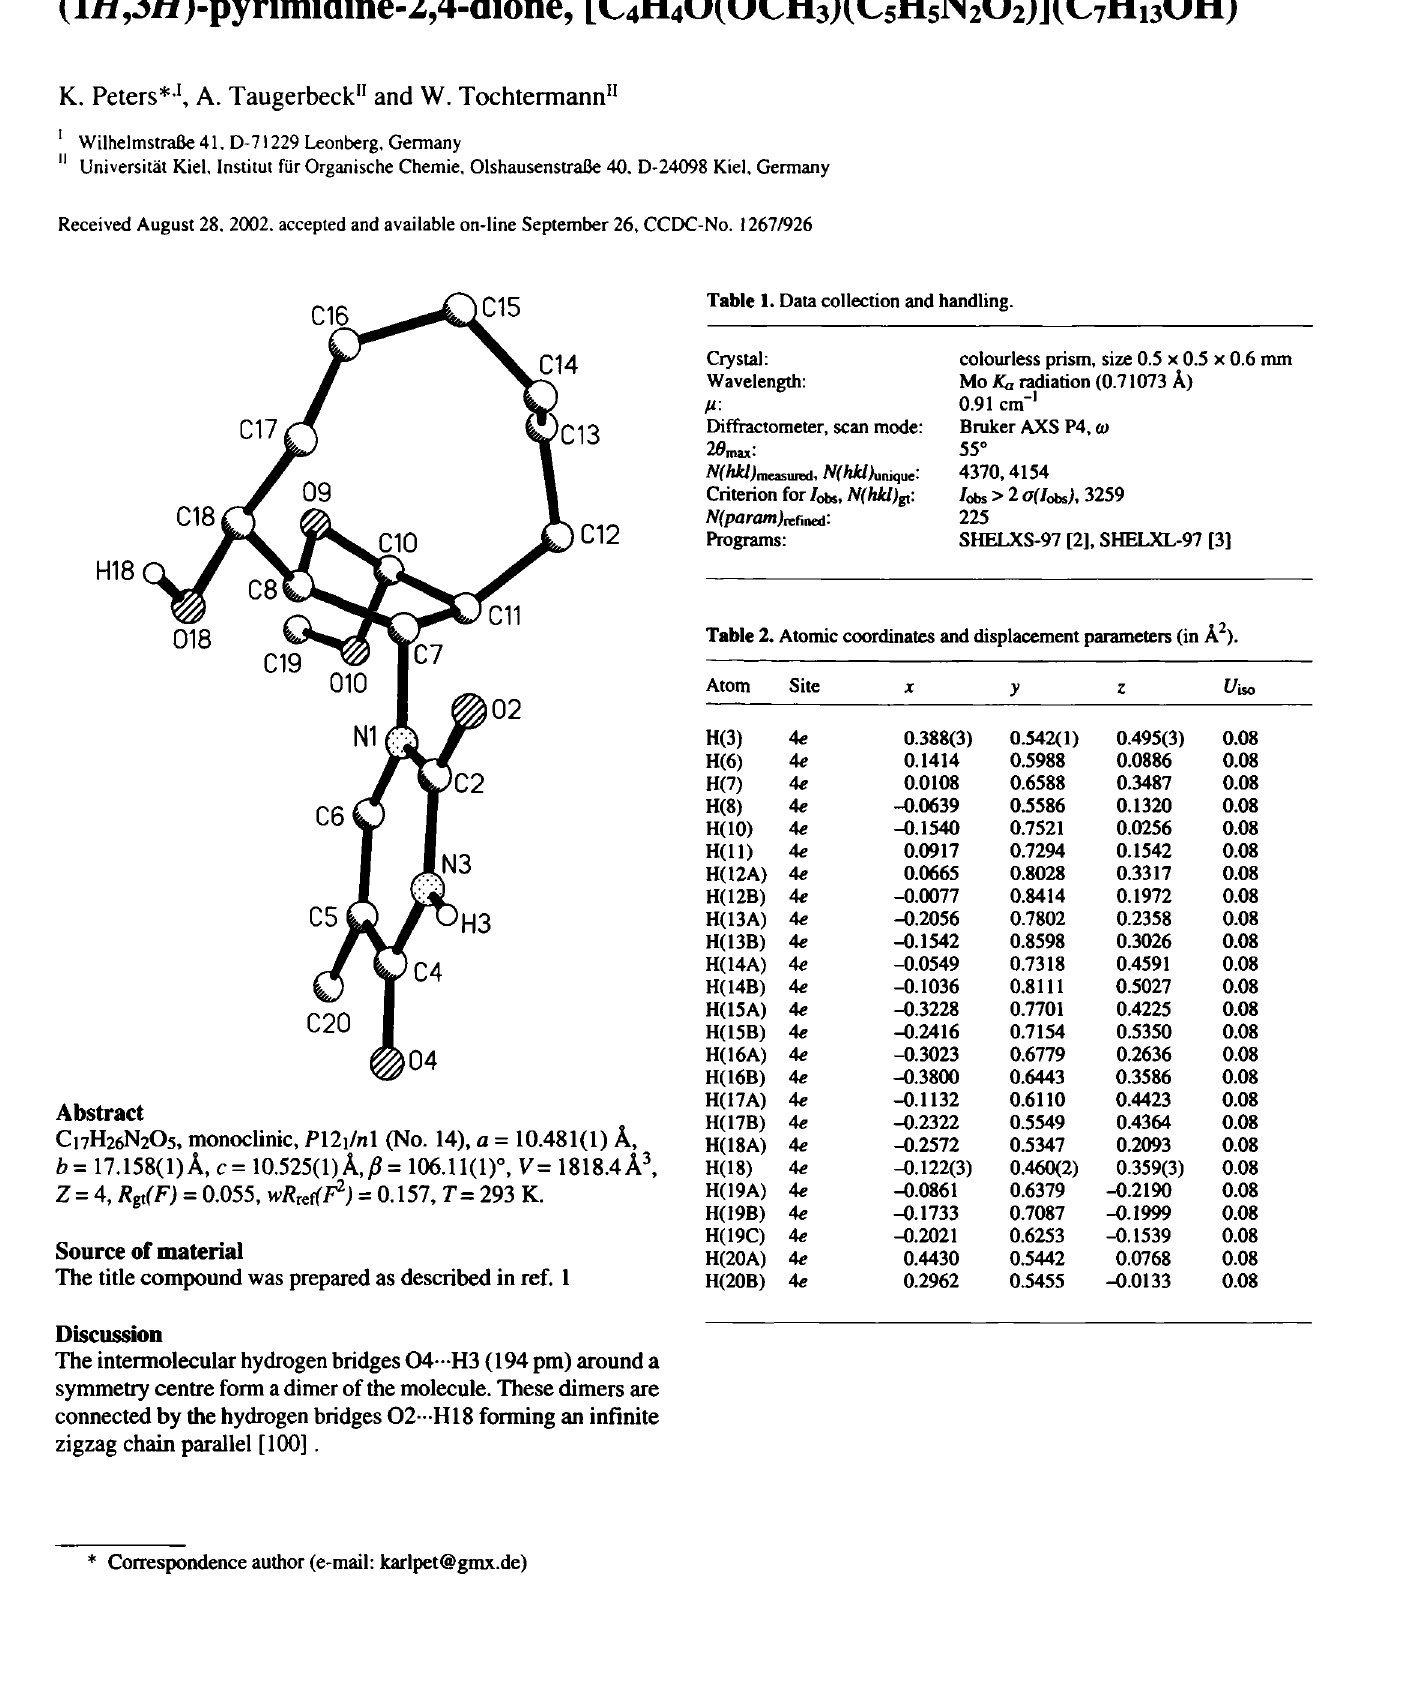
Table 2. Atomic coordinates and displacement parameters (in Â 2